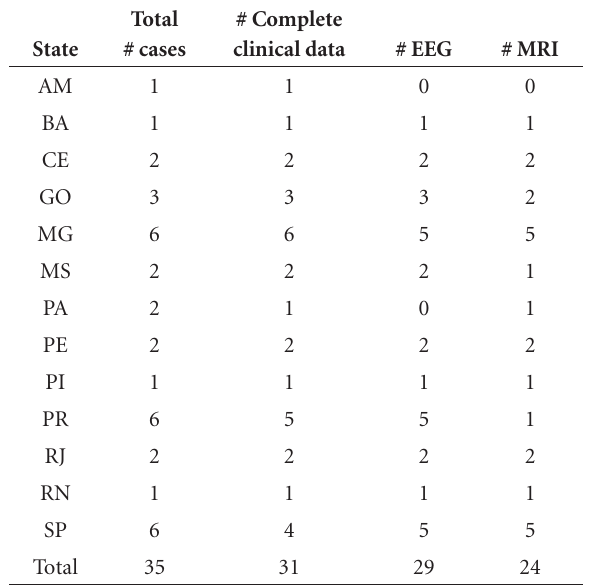
Table 7. Data available in the notification form at the time 14.3.3 and/or PRNP analysis were requested (distribution by Brazilian States where cases were